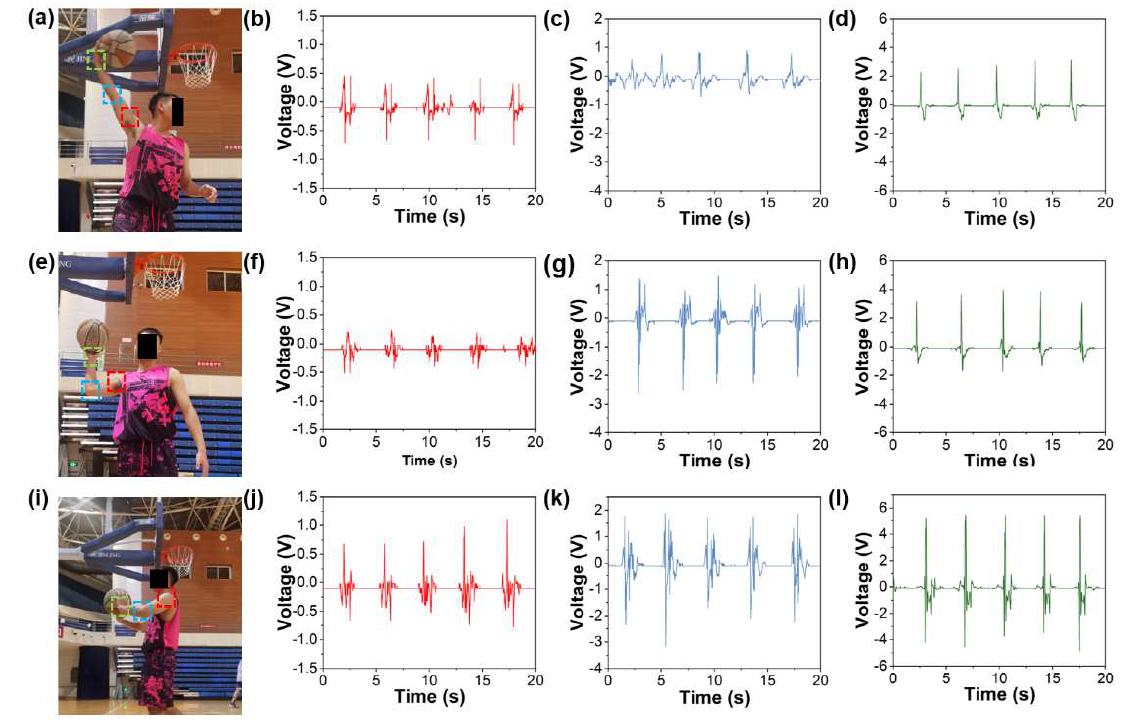
Figure 6. ( a ) Image of hook pass. ( b – d ) Outputting piezoelectric voltage of the shoulder, elbow, and wrist in hook pass motion. ( e ) Image of the shoulder pass. ( f – h ) Outputting piezoelectric voltage of the shoulder, elbow, and wrist in a shoulder pass motion. ( i ) Image of the chest pass. ( j – l ) Outputting piezoelectric voltage of the shoulder, elbow, and wrist in a chest pass motion.